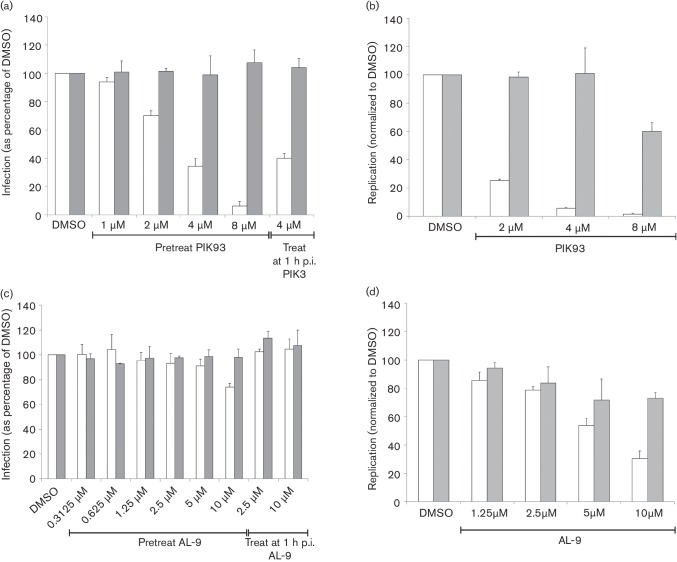
(a, c) IBRS2 cells in 96-well plates were pre-treated for 1 h with PIK93 (a) or AL-9 (c) at the concentrations indicated (or DMSO as a control) and then infected with FMDV (grey bars) or BEV-1 (white bars) at (m.o.i.=0.3) in the presence of drug for 1 h. Virus was washed away, and then infection continued for a further 3 h (FMDV) or 4 h (BEV-1). Infection was stopped, the cells were fixed and permeabilized, and infected cells were identified as described in Methods. The results were normalized to the DMSO-treated controls. Shown are the means±sd for triplicate wells. Each panel shows one experiment representative of two conducted, each giving similar results. (b, d) IBRS2 cells in white-walled 96-well plates were transfected with FMDV (grey bars) or CVB3 (white bars) renilla luciferase replicon RNA and incubated at 37 °C in the presence of PIK93 (b) or AL-9 (d) at the concentrations indicated (or DMSO as a control) and Enduren renilla luciferase substrate. Luminescence was measured after 5 h (FMDV replicon) or 6 h (CVB3 replicon). The results were normalized to the DMSO-treated controls. Shown are the means±sd for triplicate wells. Each panel shows one experiment representative of two conducted, each giving similar results.